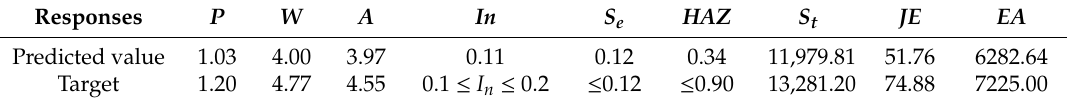
Table 16. Targets and optimized values for all the responses involved in the optimization problem.